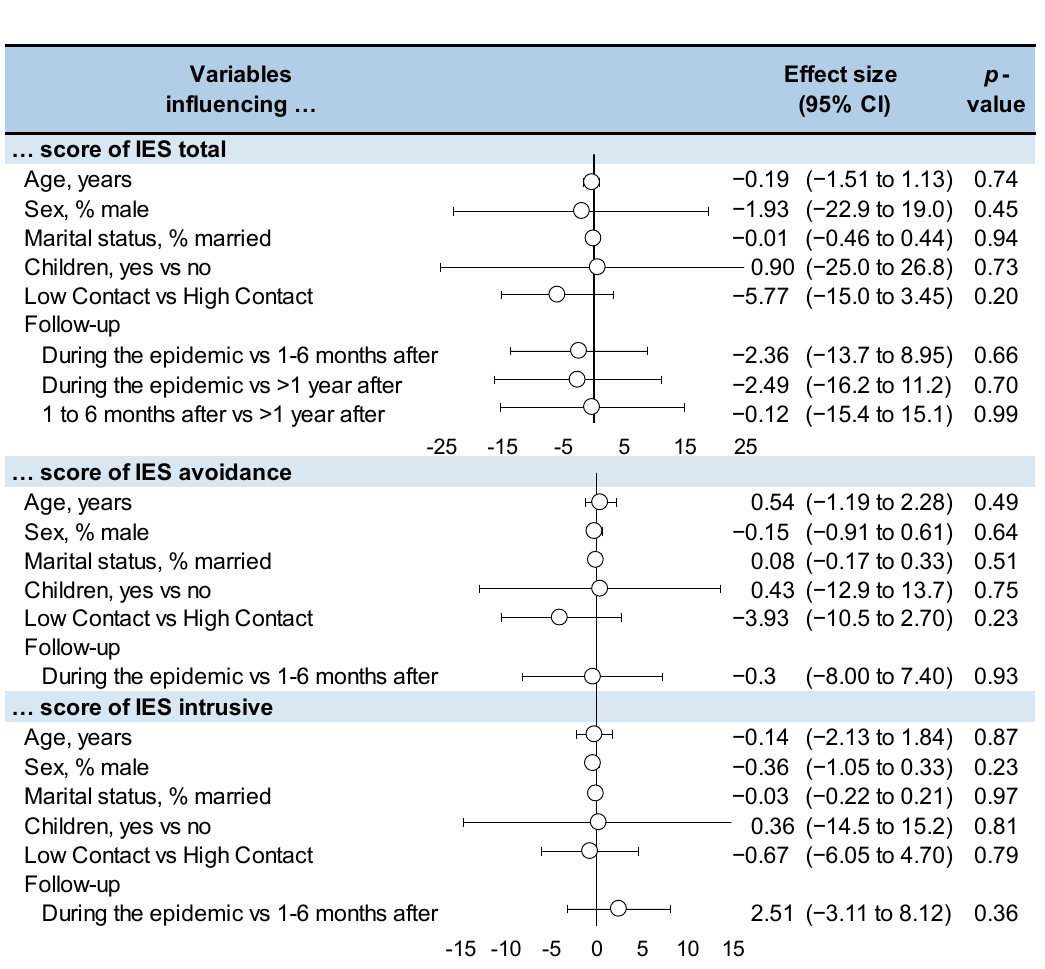
Figure A5. Factors influencing (meta-regressions) IES score (total, intrusive, and avoidance) following the SARS-Co-V1 epidemic of 2003. Each summary of meta-analysis is represented in the forest-plot by a white circle (dot) on a horizontal line.